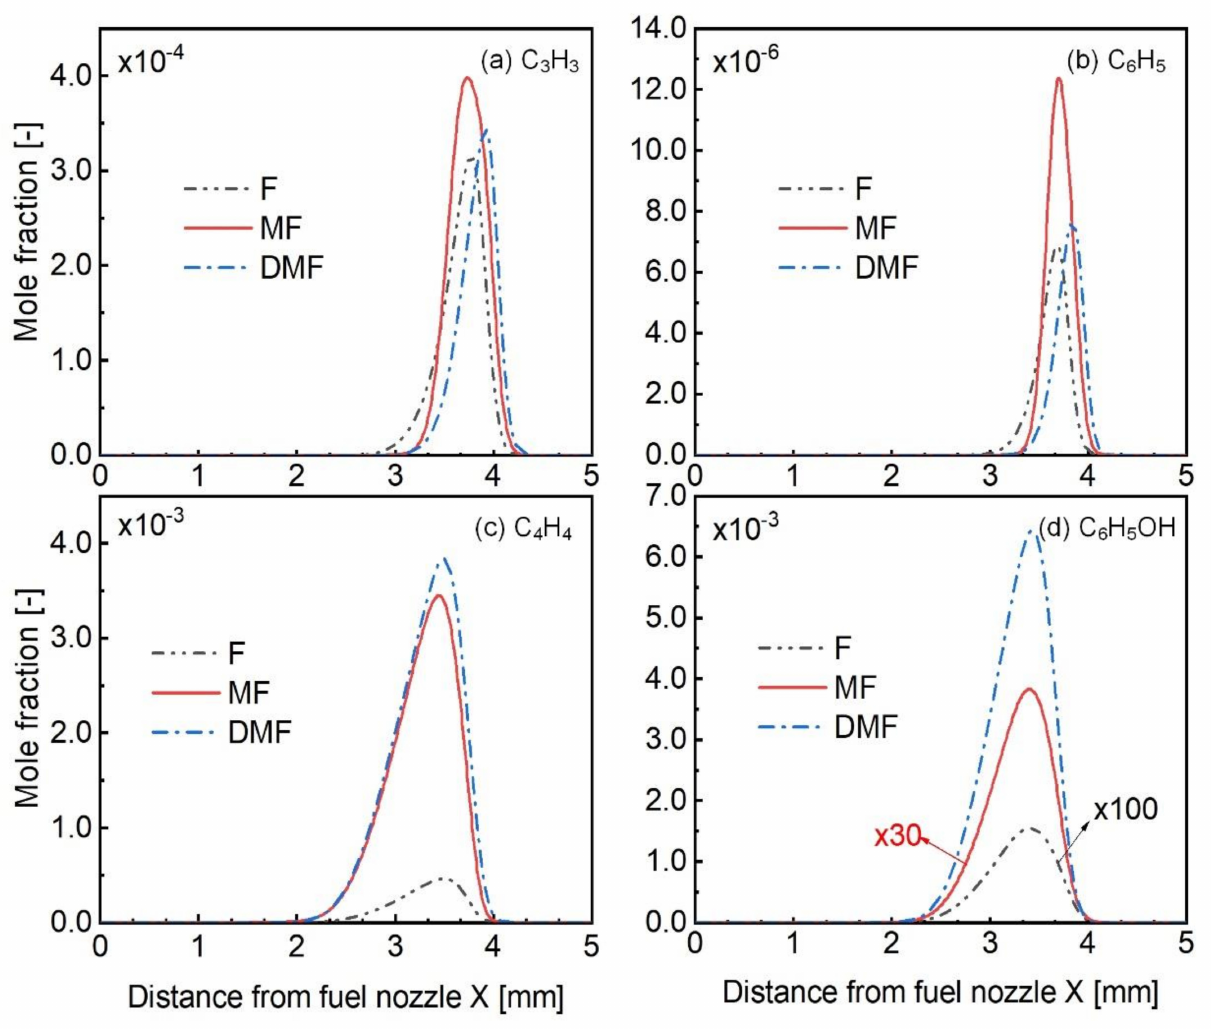
Figure 8. Computed mole fractions of several important species, including ( a ) C 3 H 3 , ( b ) C 6 H 5 , ( c ) C 4 H 4 and ( d ) C 6 H 5 OH during the combustion of furan, MF, and